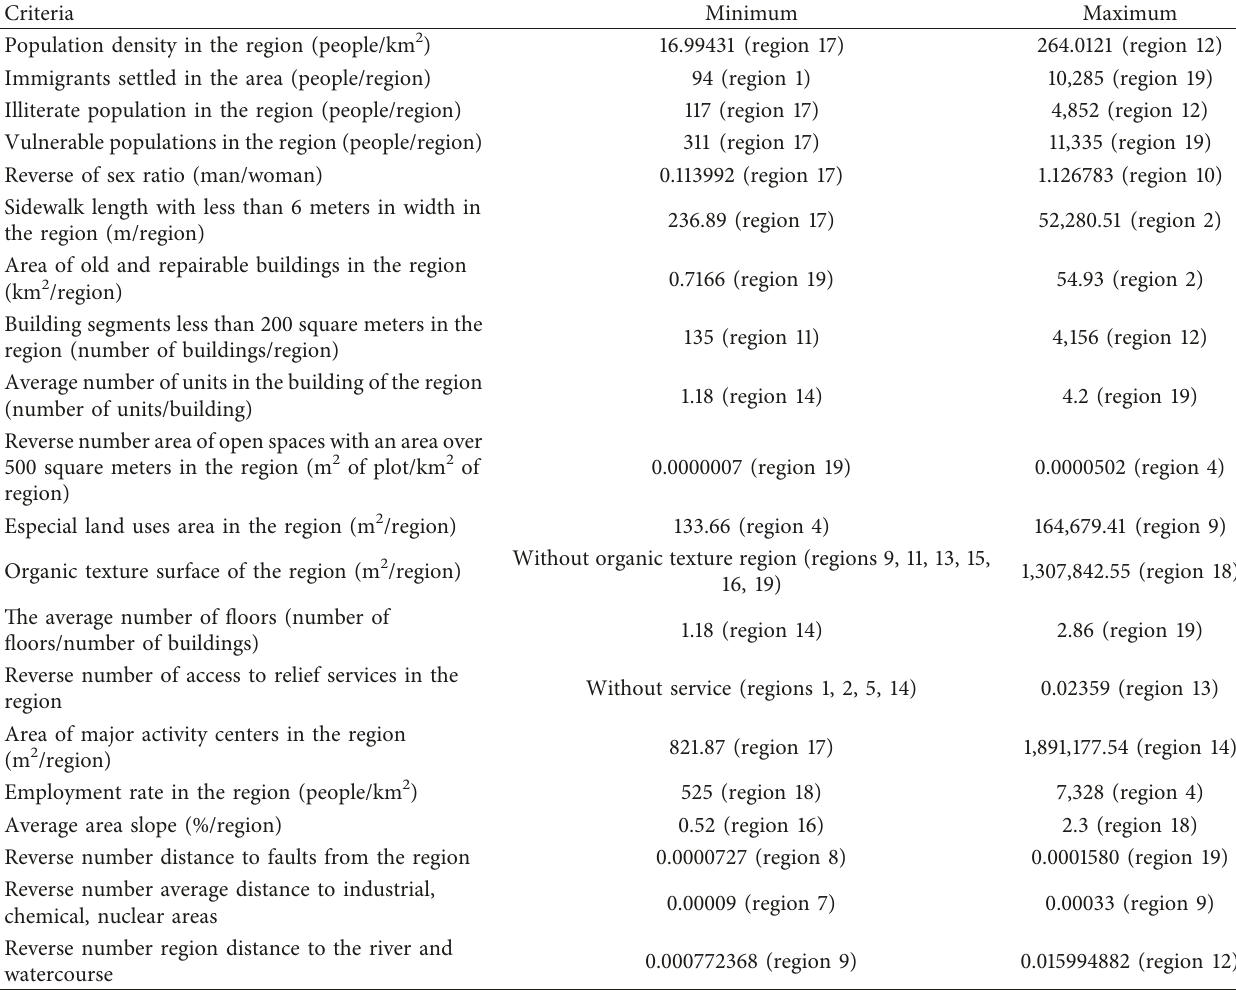
Table 4: Vulnerability subcriteria